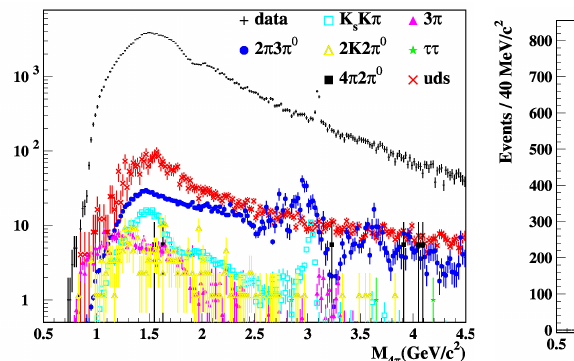
channel e + e − → π + π − 3 π 0 was measured from B A B AR data. The result is shown in Fig. 1b and enables us to adjust the existing Monte Carlo samples to reflect the measured five pion mass